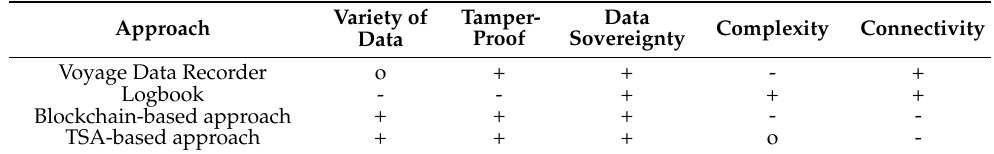
Tamper- Data Variety of Complexity Connectivity Proof Sovereignty Data